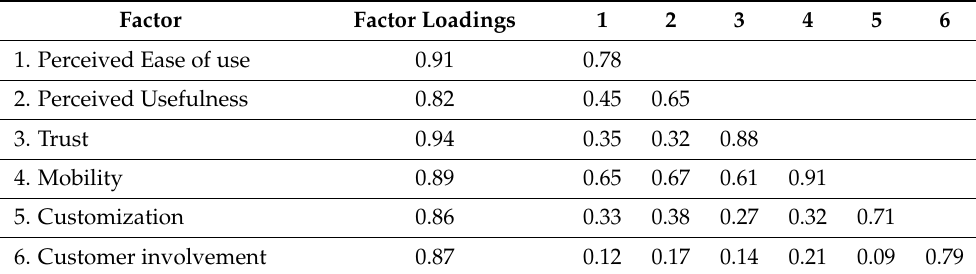
Table 4. Factor loadings.